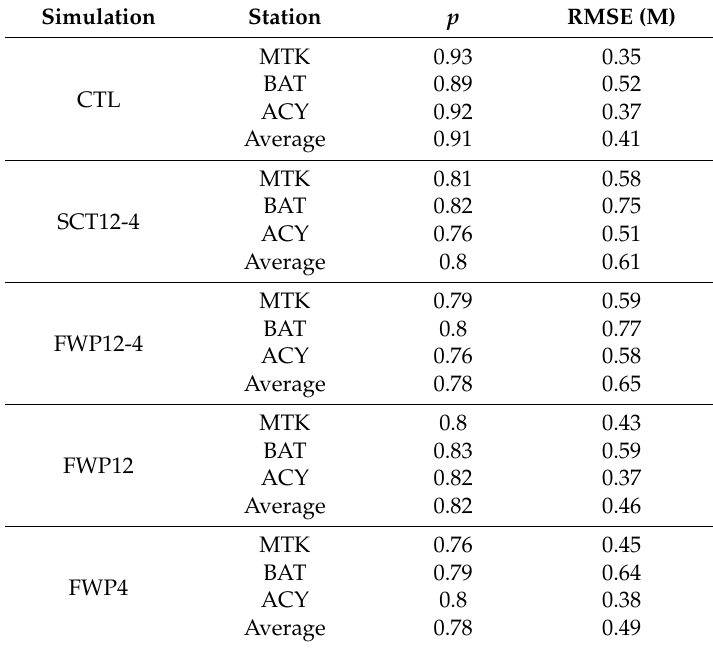
Table 4. Statistics for water elevation of each